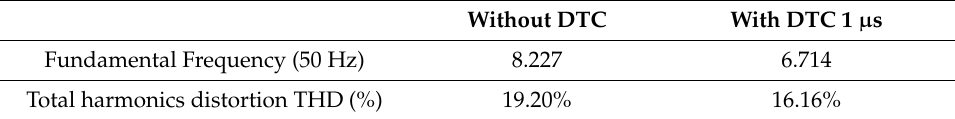
Figure 13. Calculation of total harmonic distortion (THD) without and with DTC. Table 5. FFT analysis of the load current.